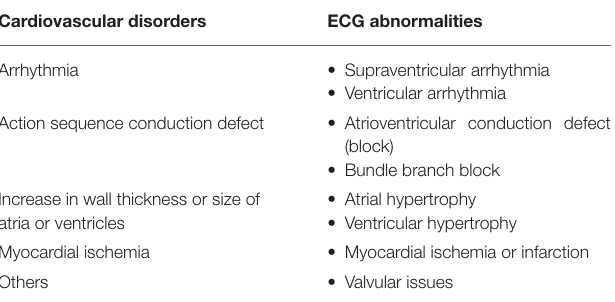
TABLE 1 | Categorization of ECG abnormalities based on expert